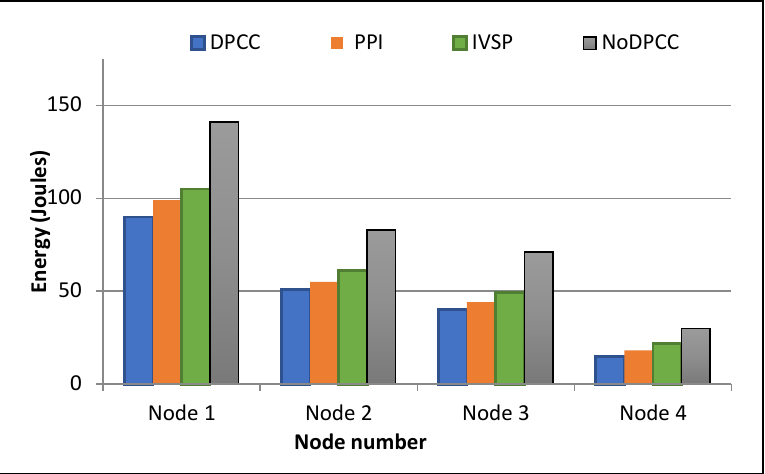
Figure 15. Energy consumption at each node.